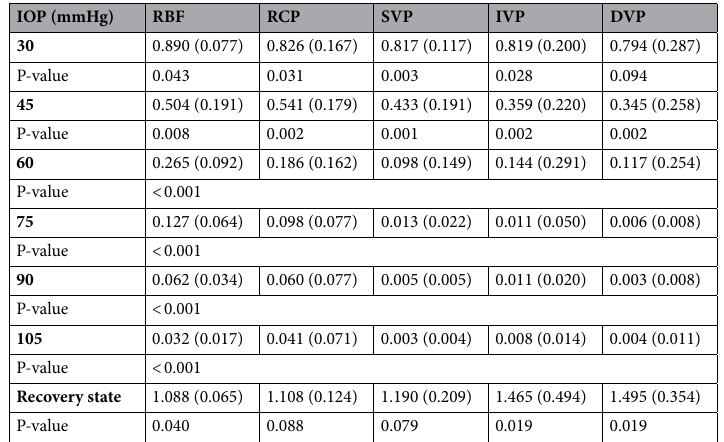
Table 1. Relative vessel area density compared to baseline (15 mmHg). All values are presented in mean (standard deviation). All P-value; repeated ANOVA test, compared with baseline (15 mmHg). RBF total retinal blood flow, RPCs radial peripapillary capillaries, SVP superficial vascular plexus, IVP intermediate vascular plexus, DVP deep vascular plexus, VAD vessel area